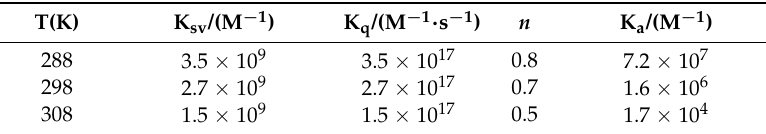
Table 1. The binding constant of hemoglobin (Hb) and paclitaxel (PTX) in amorphous nanosuspensions (ANSs) analyzed by modified Stern–Volmer